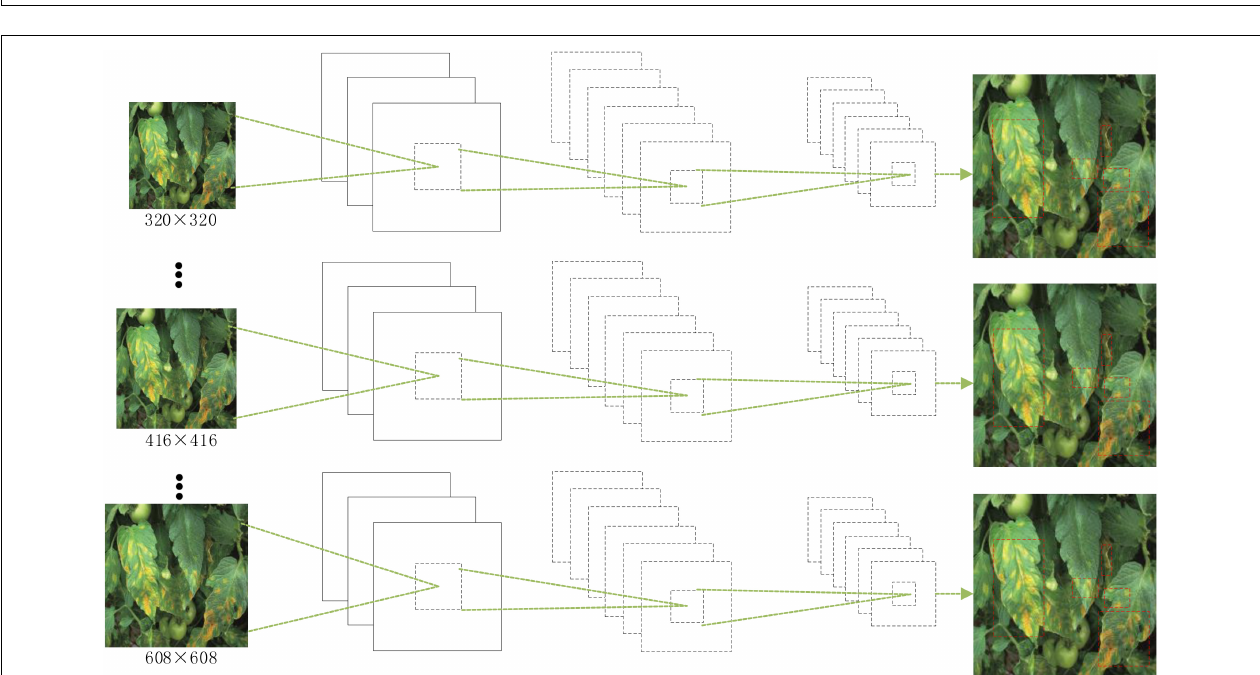
FIGURE 7 | Schematic diagram of the multiscale training